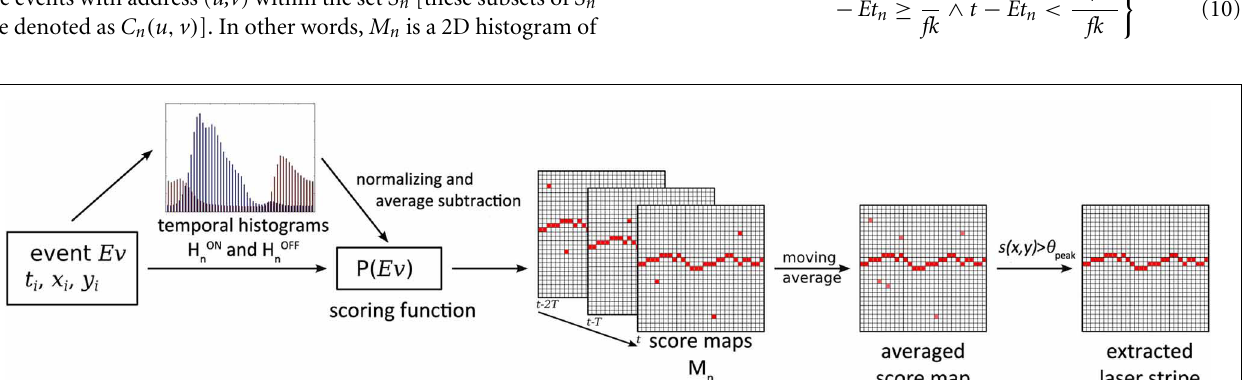
score maps. The maps are averaged and the laser stripe is extracted by selecting the maximum scoring pixel for each column, if it is above the threshold θ peak .